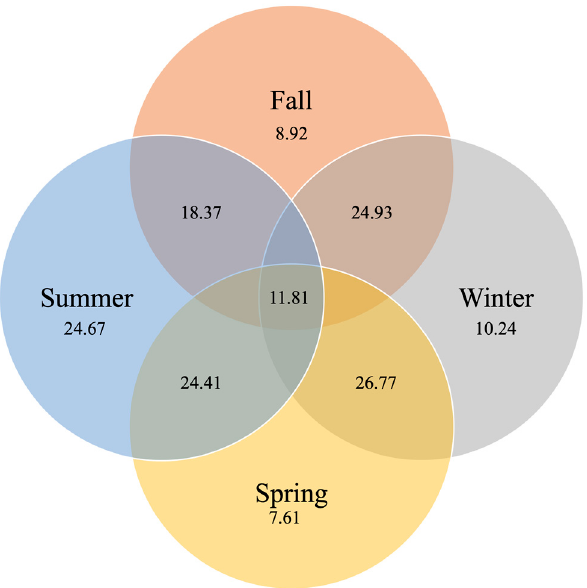
Figure 4. Percentage (%) of shared and unique genera between the gut microbiome samples of the four tested seasons.